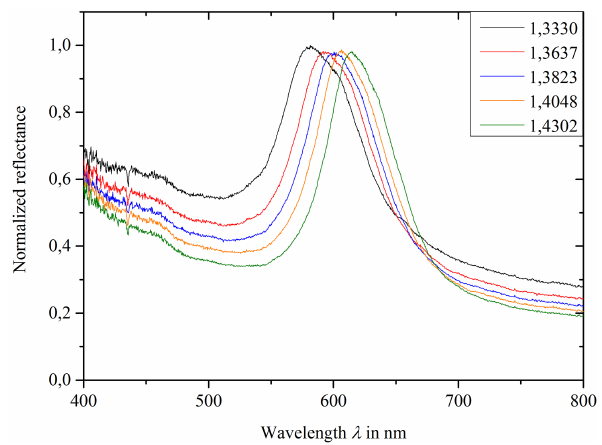
Figure 6. Normalized reflectance spectra of the WO 3 inverse opal structure infiltrated with different water–ethylene-glycol mixtures.